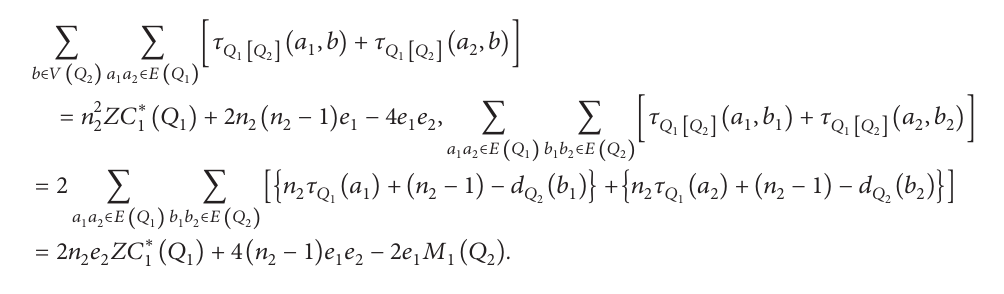
� P , and (c) closed fence ( C 2 2